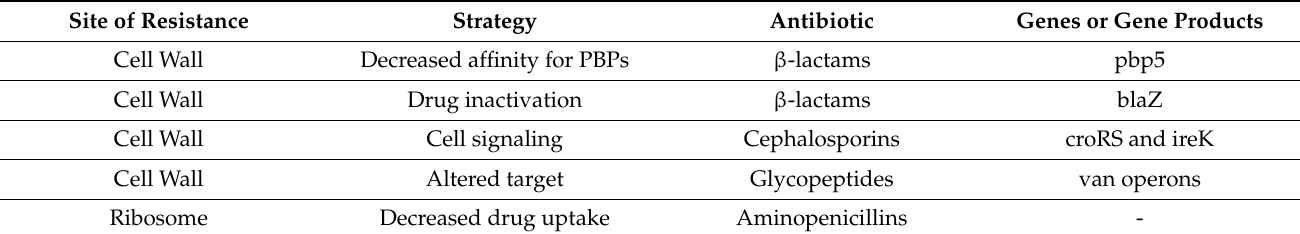
Table 2. Multidrug-resistant pathways in Enterococcus